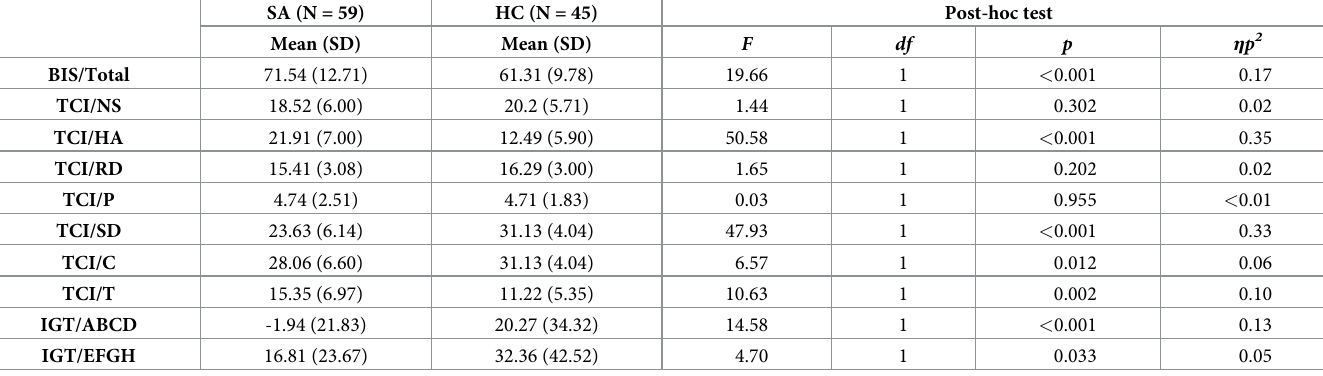
Table 1. Adjusted personality and decision-making differences between individuals with a diagnosis of major depressive disorder and a recent Suicide Attempt (SA) and Healthy Controls